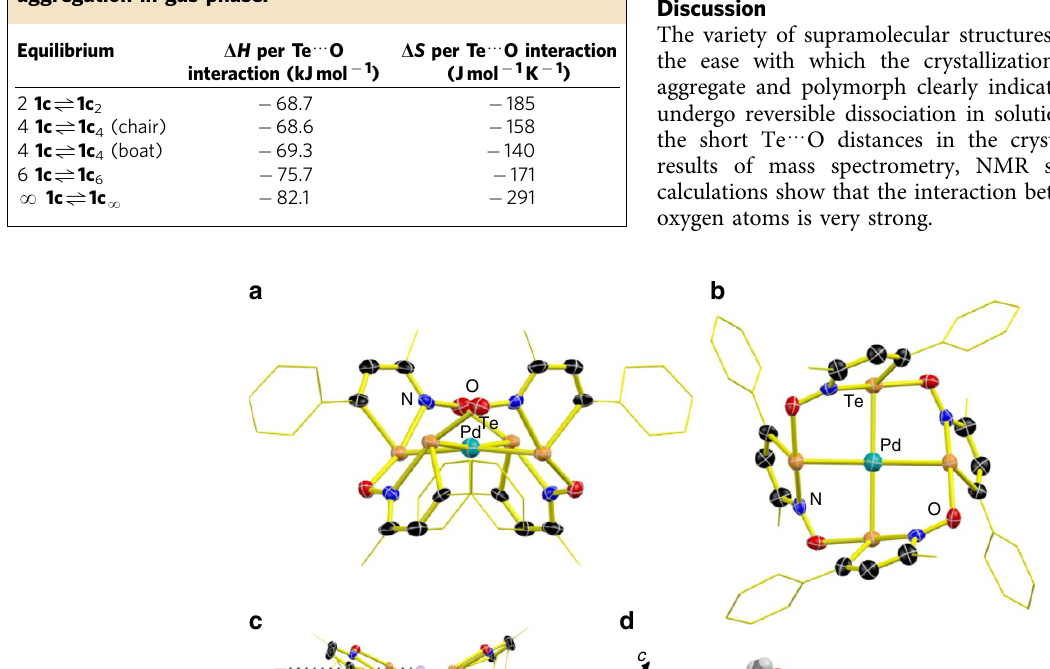
Table 1 | Calculated (PBE-D3) thermodynamic parameters of aggregation in gas